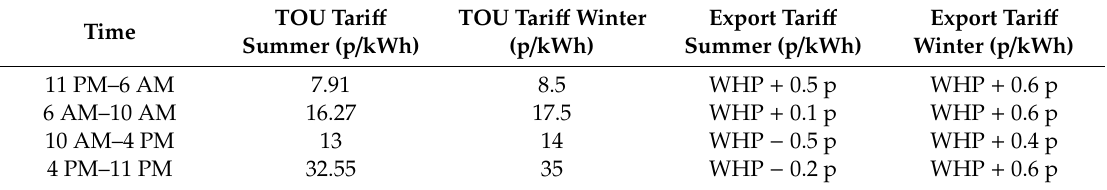
Table 2. Time of use and export tari ff s [36] (wholesale price, WHP, for electricity is 6.1 p / kWh). TOU Tari ff Time